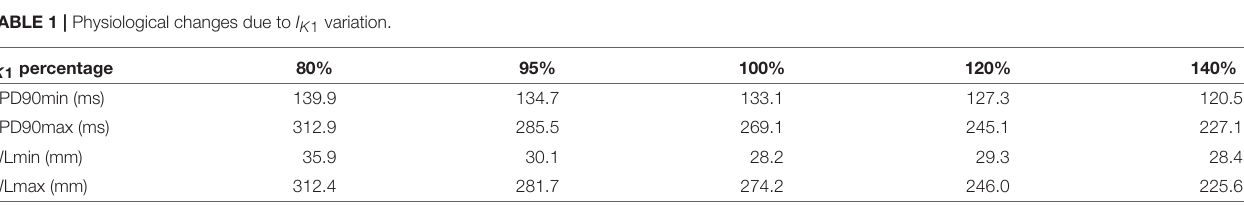
TABLE 1 | Physiological changes due to I K 1 variation.